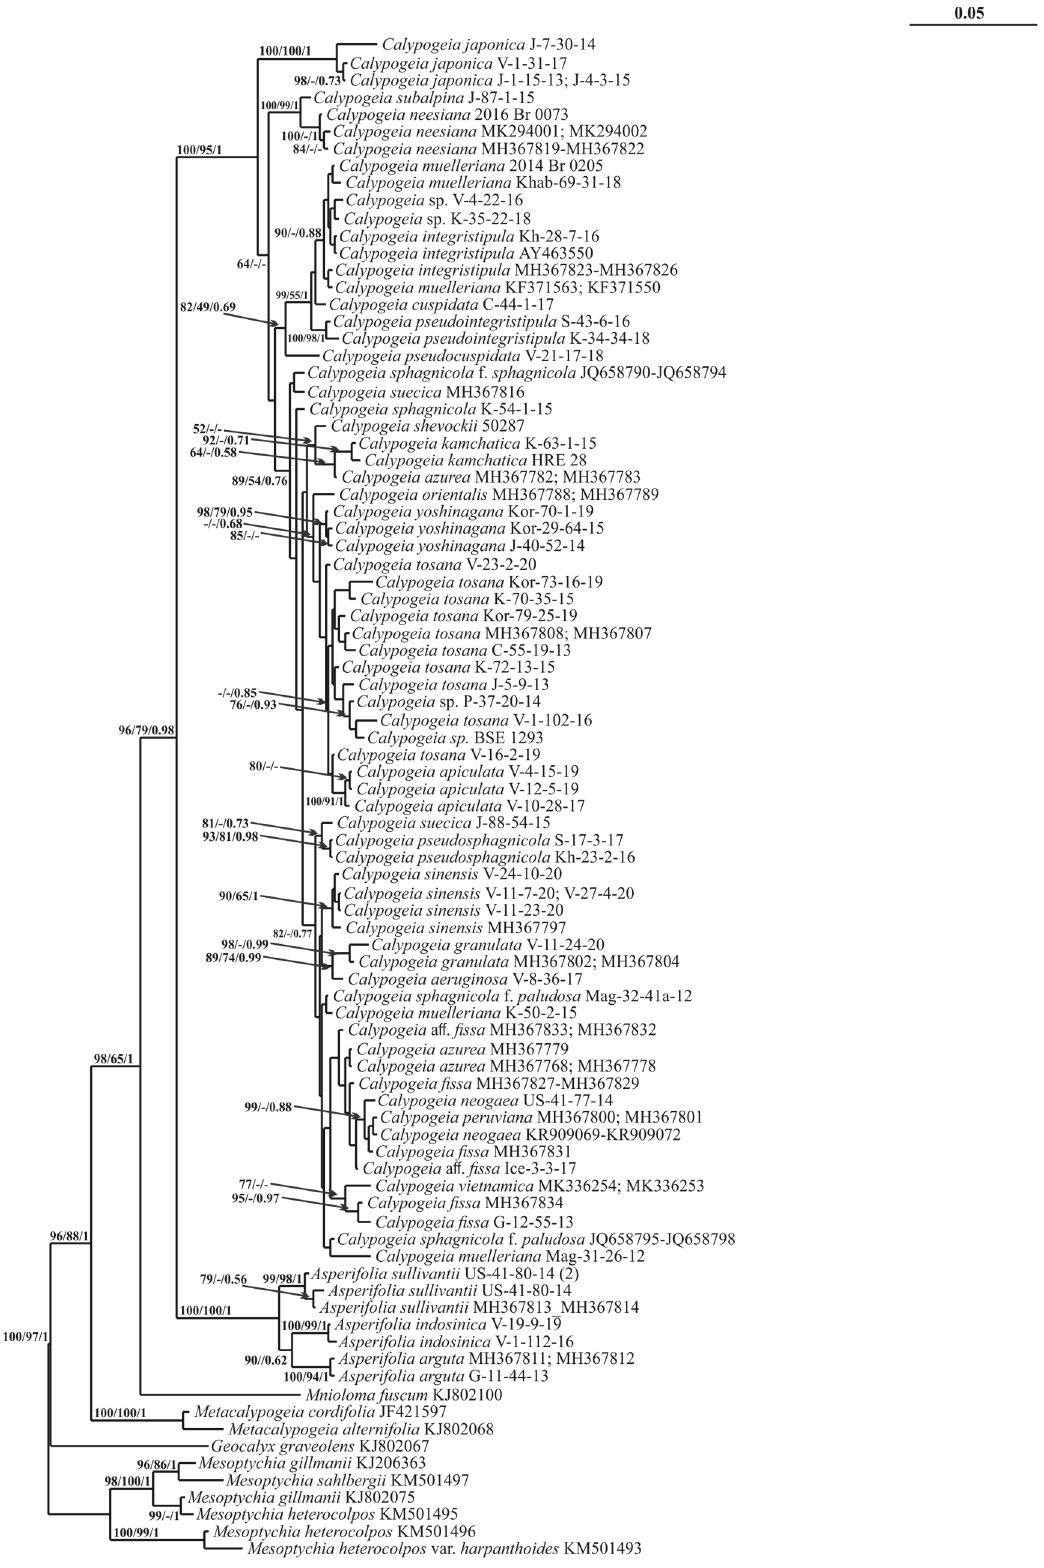
Figure 4. Phylogram obtained in a Bayesian analysis for the genus Calypogeia and related taxa based on trn L–F. Bootstrap support values > 50% in MP and ML analyses and Bayesian posterior probabilities > 0.50 are indicated. Scale bar denotes number of nucleotide substitutions per site.